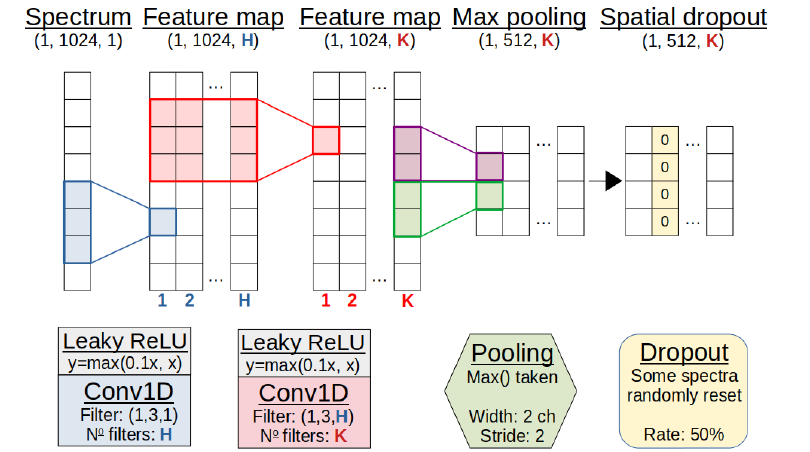
Figure 4. Representation of the convolution module. An array of intensities represents the spectrum. This trains first H filters, then K filters in two convolution layers to emphasise key features in the spectra. Pooling and dropout then reduce the dimensionality and combat over-fitting. For demonstration purposes, the shapes exclude a dimension for batch size. See text for